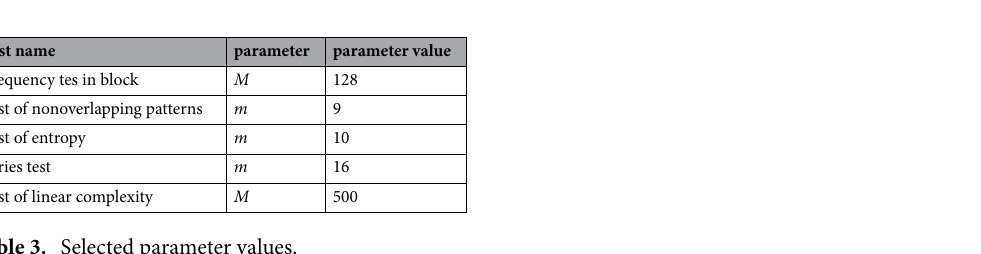
Table 3. Selected parameter